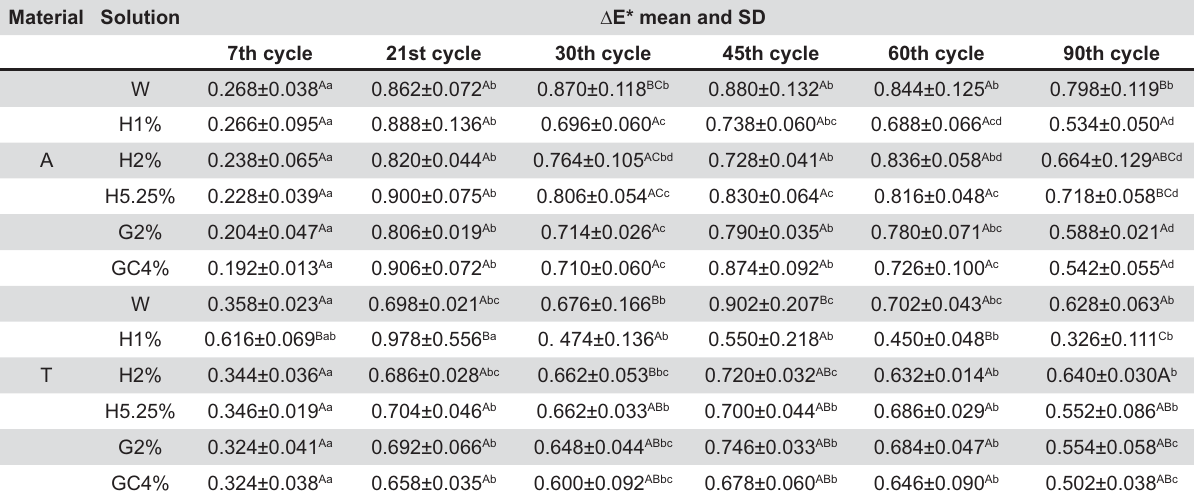
Table 1- (cid:2)(cid:3)(cid:4)(cid:5)(cid:2)(cid:6)(cid:7)(cid:8)(cid:9)(cid:2)(cid:8)(cid:9)(cid:10)(cid:2)(cid:11)(cid:12)(cid:8)(cid:9)(cid:10)(cid:8)(cid:13)(cid:10)(cid:2)(cid:10)(cid:7)(cid:14)(cid:15)(cid:8)(cid:12)(cid:15)(cid:16)(cid:9)(cid:2)(cid:17)(cid:18)(cid:19)(cid:20)(cid:2)(cid:21)(cid:16)(cid:13)(cid:2)(cid:7)(cid:8)(cid:22)(cid:23)(cid:2)(cid:10)(cid:7)(cid:9)(cid:12)(cid:24)(cid:13)(cid:7)(cid:2)(cid:12)(cid:16)(cid:16)(cid:12)(cid:23)(cid:2)(cid:13)(cid:7)(cid:11)(cid:15)(cid:9)(cid:2)(cid:6)(cid:8)(cid:12)(cid:7)(cid:13)(cid:15)(cid:8)(cid:25)(cid:2)(cid:8)(cid:22)(cid:22)(cid:16)(cid:13)(cid:10)(cid:15)(cid:9)(cid:26)(cid:2)(cid:12)(cid:16)(cid:2)(cid:12)(cid:23)(cid:7)(cid:2)(cid:12)(cid:7)(cid:11)(cid:12)(cid:7)(cid:10)(cid:2)(cid:11)(cid:16)(cid:25)(cid:24)(cid:12)(cid:15)(cid:16)(cid:9)(cid:11)(cid:2)(cid:27)(cid:15)(cid:12)(cid:23)(cid:15)(cid:9)(cid:2) each period of